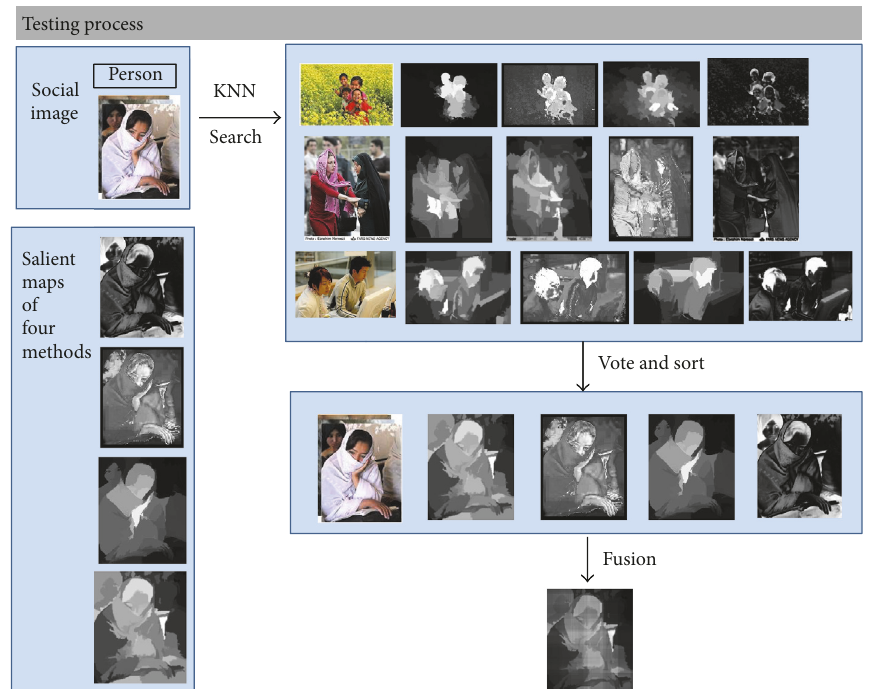
Figure 6: Testing